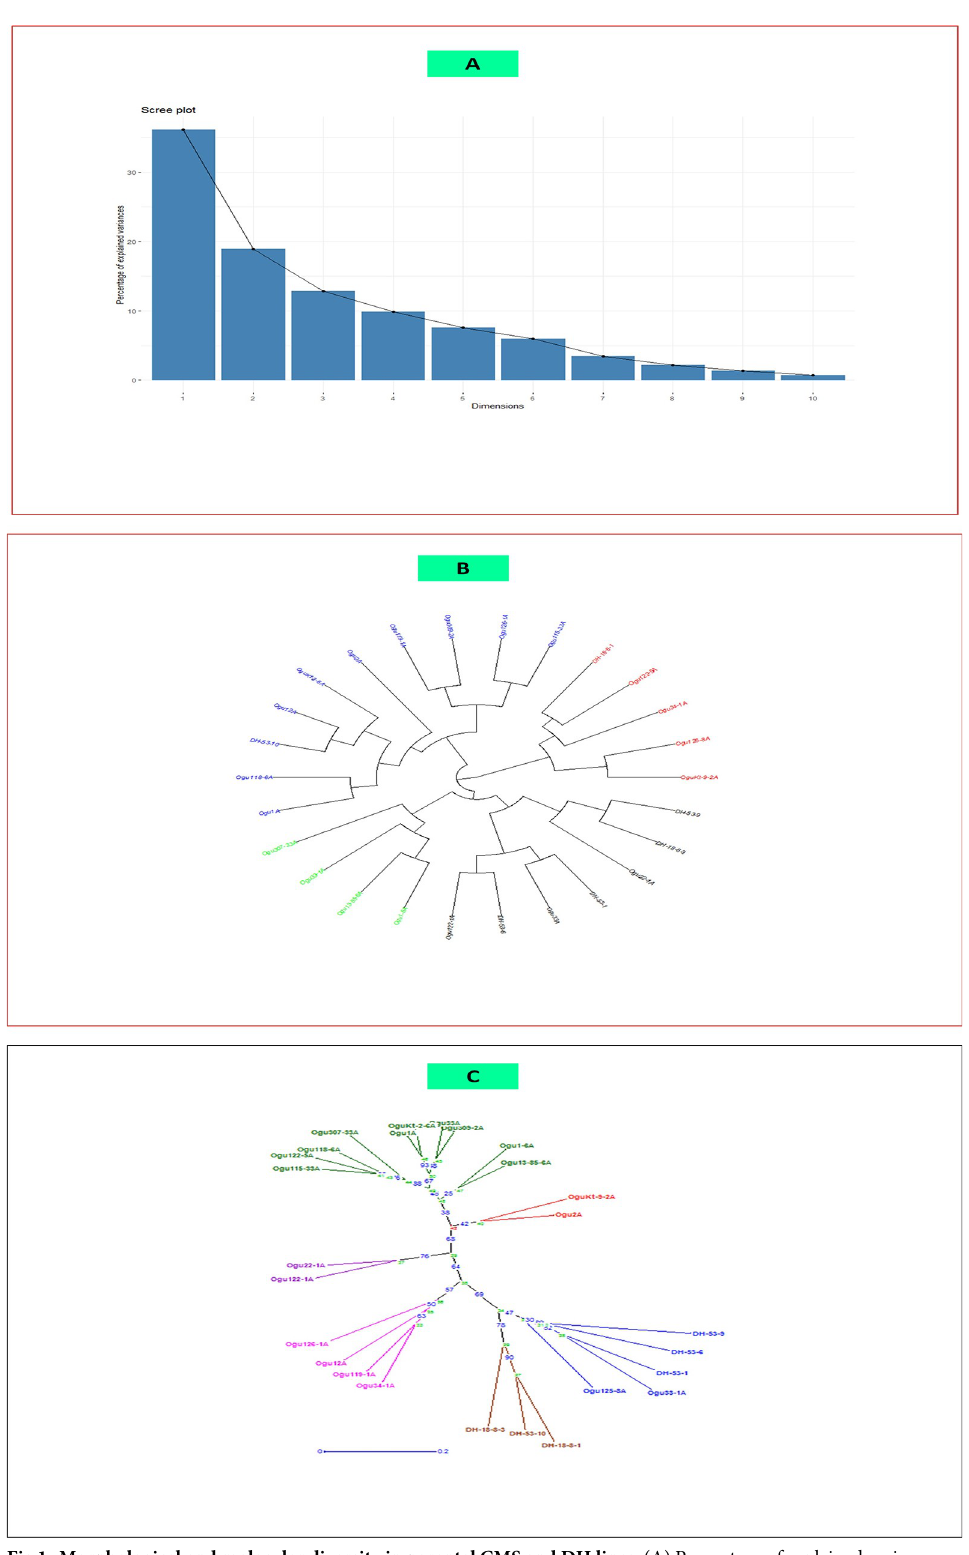
Fig 1. Morphological and molecular diversity in parental CMS and DH lines. (A) Percentage of explained variance among parental genotypes in different principal components (B) Dendrogram illustrating the genetic relationships